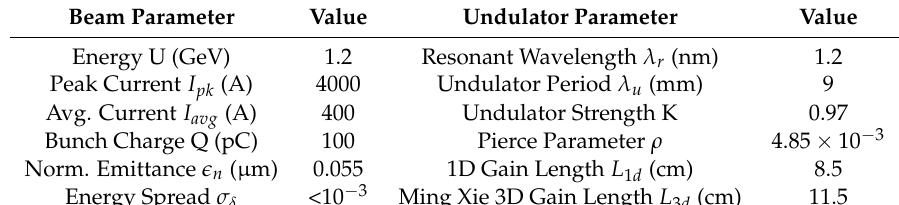
Table 1. The nominal design parameters for a soft X-ray free-electron laser (XFEL) are given. Beam parameters are based on a cryogenic-rf photoinjector, and undulator parameters are based on cryogenic, small-gap undulator work performed at the University of California, Los Angeles (UCLA) [12].